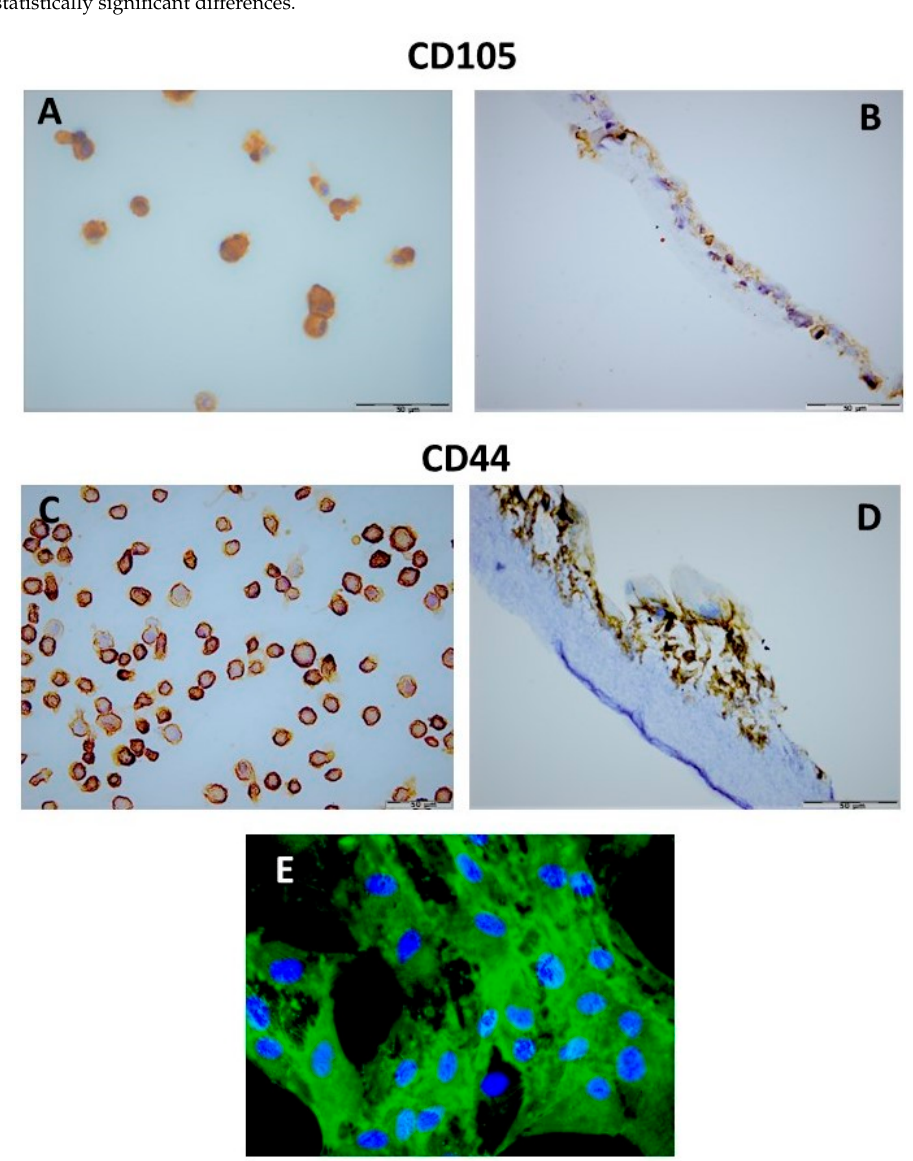
Figure 3. hDPSCs grown as a monolayer and on PLCL mat for seven days immunohistochemically stained for CD105 and CD44. ( A ) membrane expression of CD105 on hDPSCs grown as a monolayer ( B ) and grown on PLCL. ( C ) high CD44 expression detected in the majority of hDPSCs grown as a monolayer ( D ) and on the PLCL scaffold, ( E ) Immunofluorescence staining for CD44 marker (green) and DAPI (blue) revealed nuclei of hDPSCs grown as monolayer. (EnVision ( A – D ) and Immunofluorescence ( E ) techniques). Scale bar = 50 μ m for ( A – D ) and magnification ×600 for ( E ).